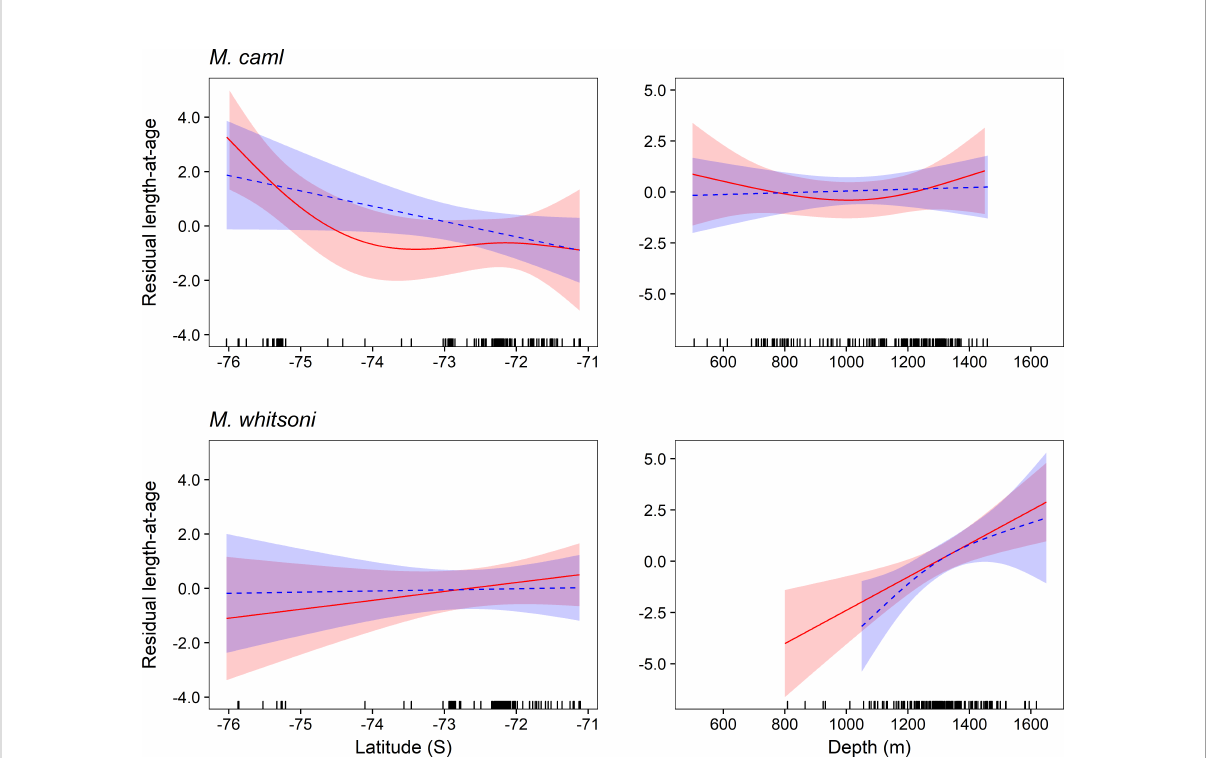
FIGURE 7 Sex-speci fi c trends in residual length-at-age for Macrourus caml (top row) and M. whitsoni (bottom row) in the Ross Sea region by latitude (left column) and depth (right column).